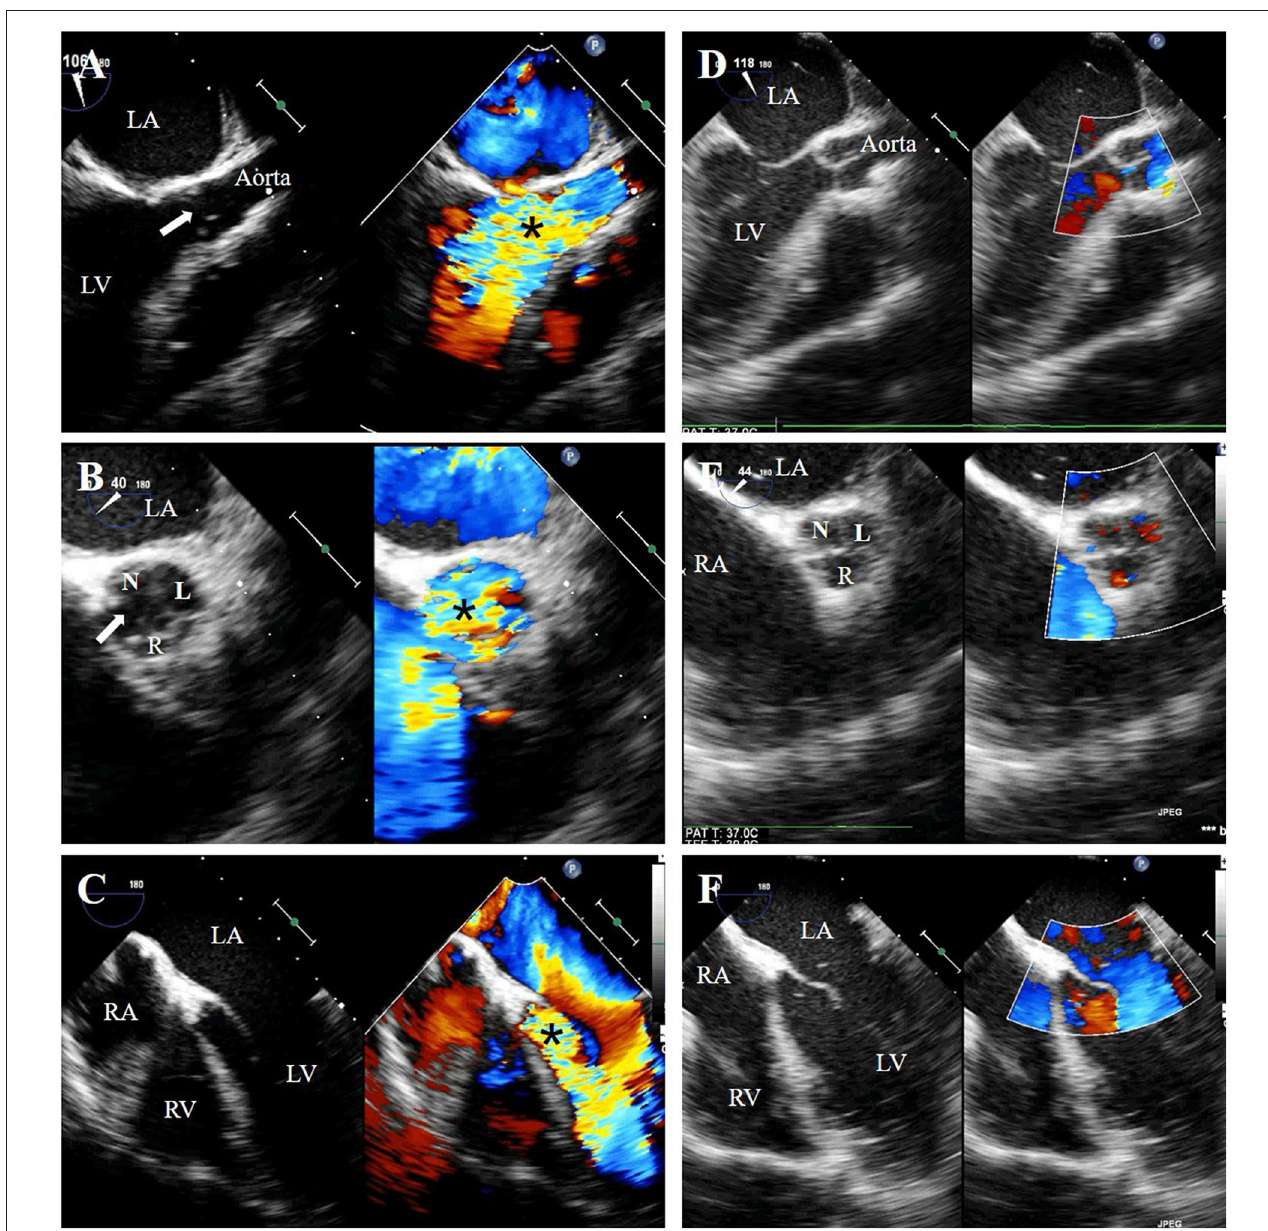
FIGURE 3 | Preoperative transesophageal echocardiography (TEE) showed free-flow aortic regurgitation (black asterisk), which is caused by a fissure (white arrow) formed between the flailed right coronary cusp and non-coronary cusp, on the long-axis view (A) , short-axis view (B) and five-chamber view (C) . Postoperative TEE showed well-functioning new valves without regurgitation (D–F) . N, non-coronary cusp; R, right coronary cusp; L, left coronary cusp; LA, left atrium; RA, right atrium; LV, left ventricle; RV, right